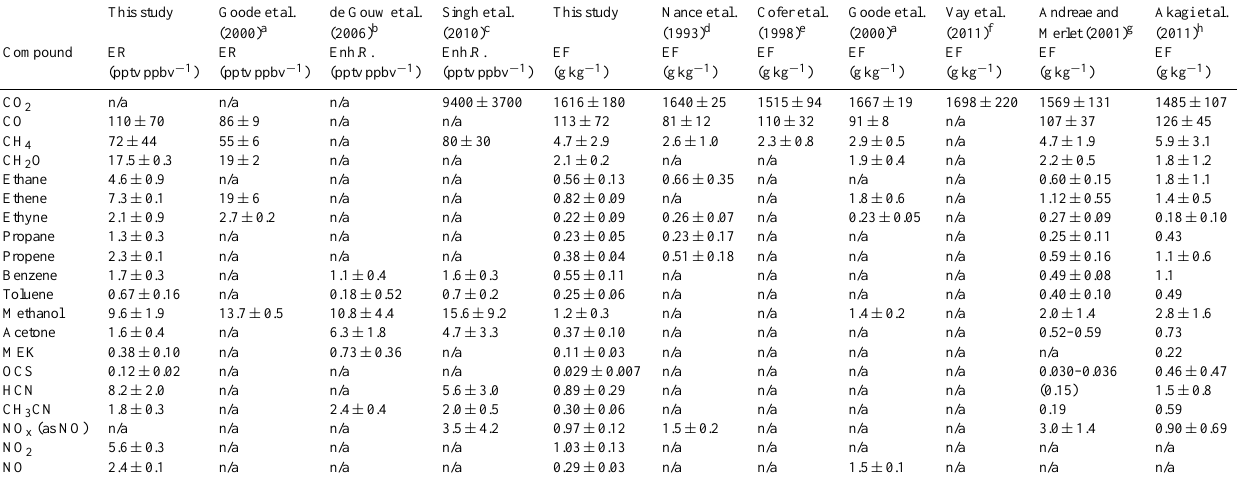
Table 3. Comparison of boreal forest fire ERs and EFs from this study with those from previous boreal forest fire studies. Note that Andreae and Merlet (2001) is a literature survey for extratropical forests that includes both boreal and temperate ecosystems. ER = emission ratio; Enh.R. = enhancement ratio; EF = emission factor; n/a = not